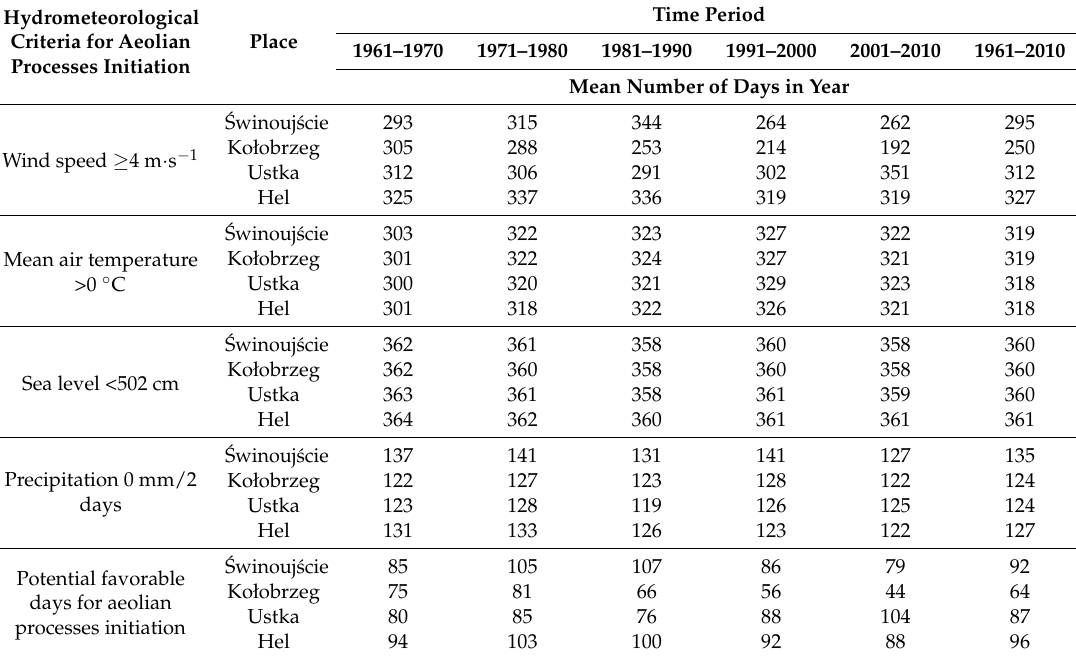
Table 1. Average number of days per year with conditions potentially favorable to initiation of aeolian processes in the Polish Baltic coastal